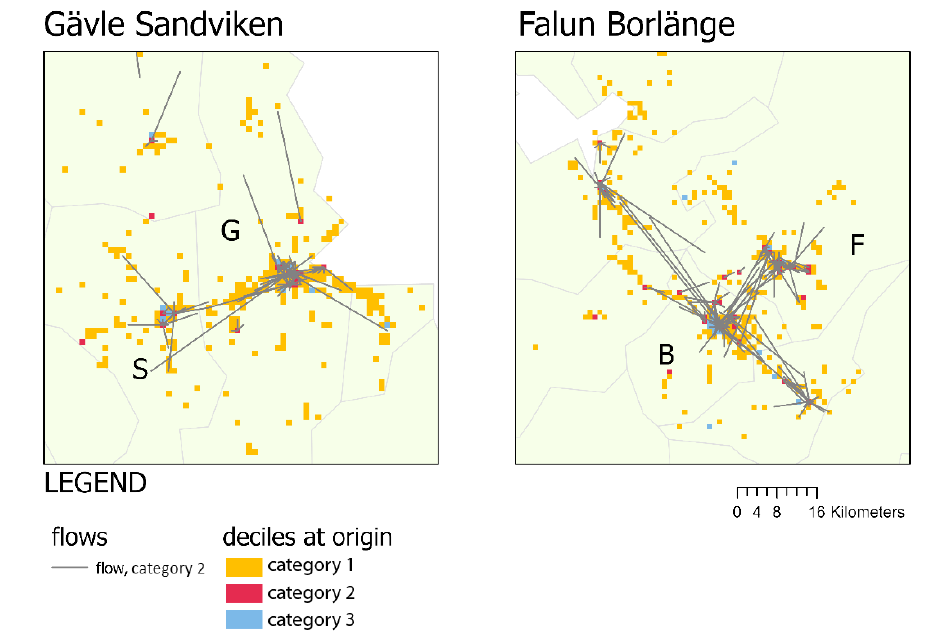
Figure 5. Flows starting in category 2. Note: Data from 28 March 2019,